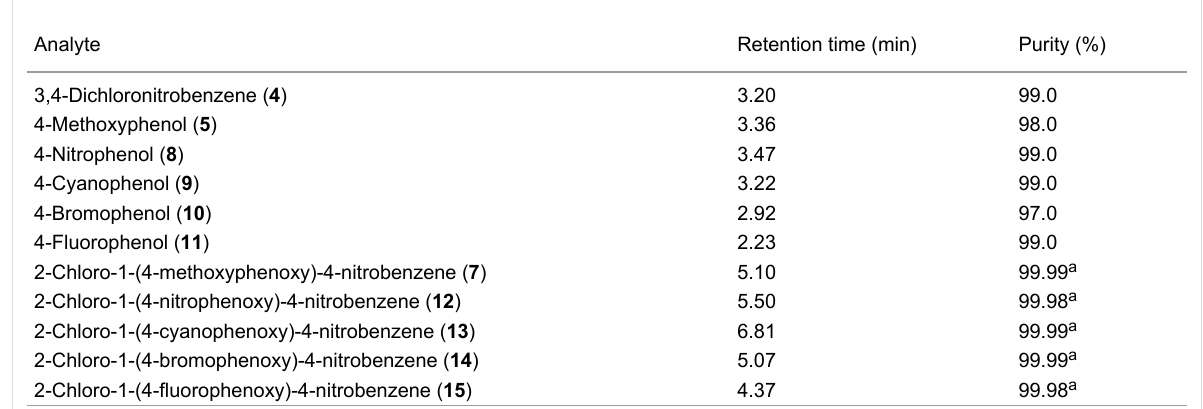
Table 3: Summary of the retention times obtained for the key starting materials and products employed herein.